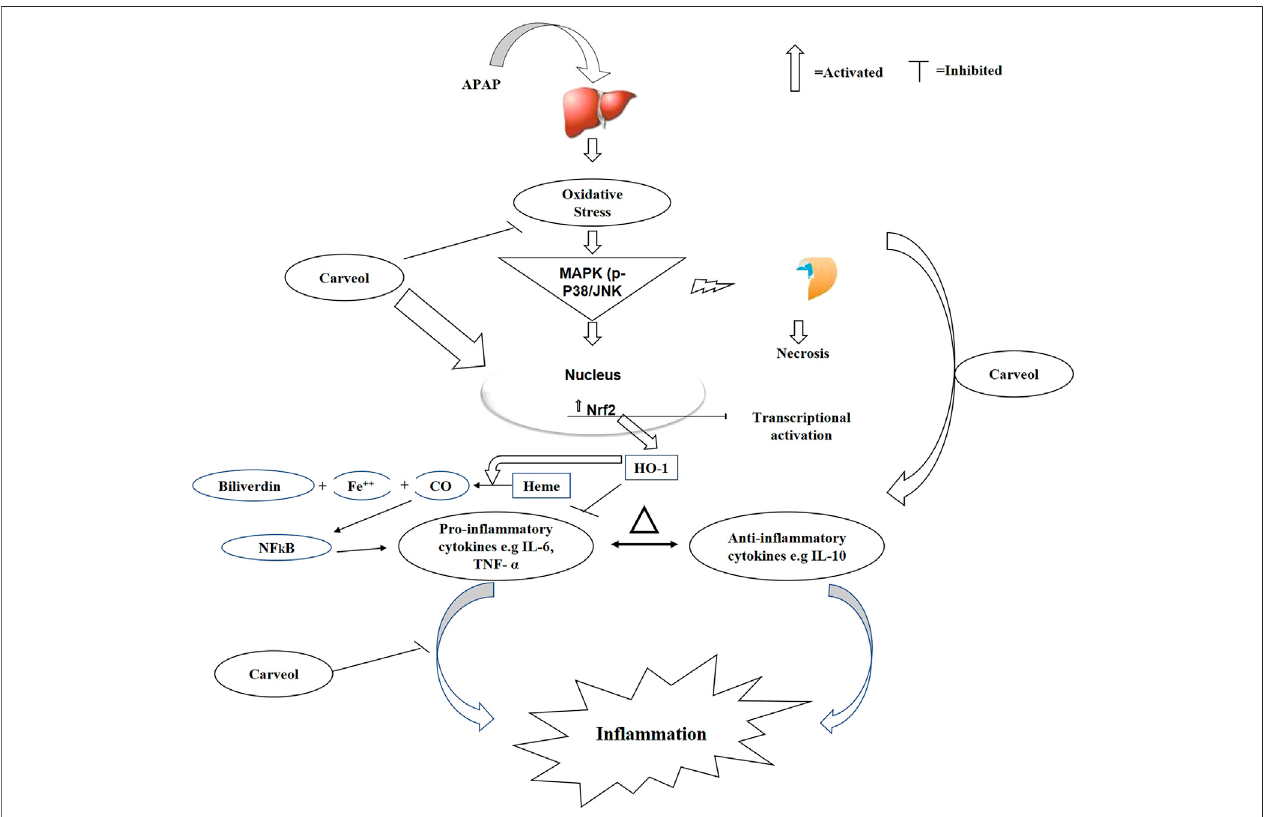
Figure 10 | The graphical representation indicates and elaborates the underlying antioxidant and anti-in fl ammatory mechanisms of carveol against the APAP- induced liver toxicity.